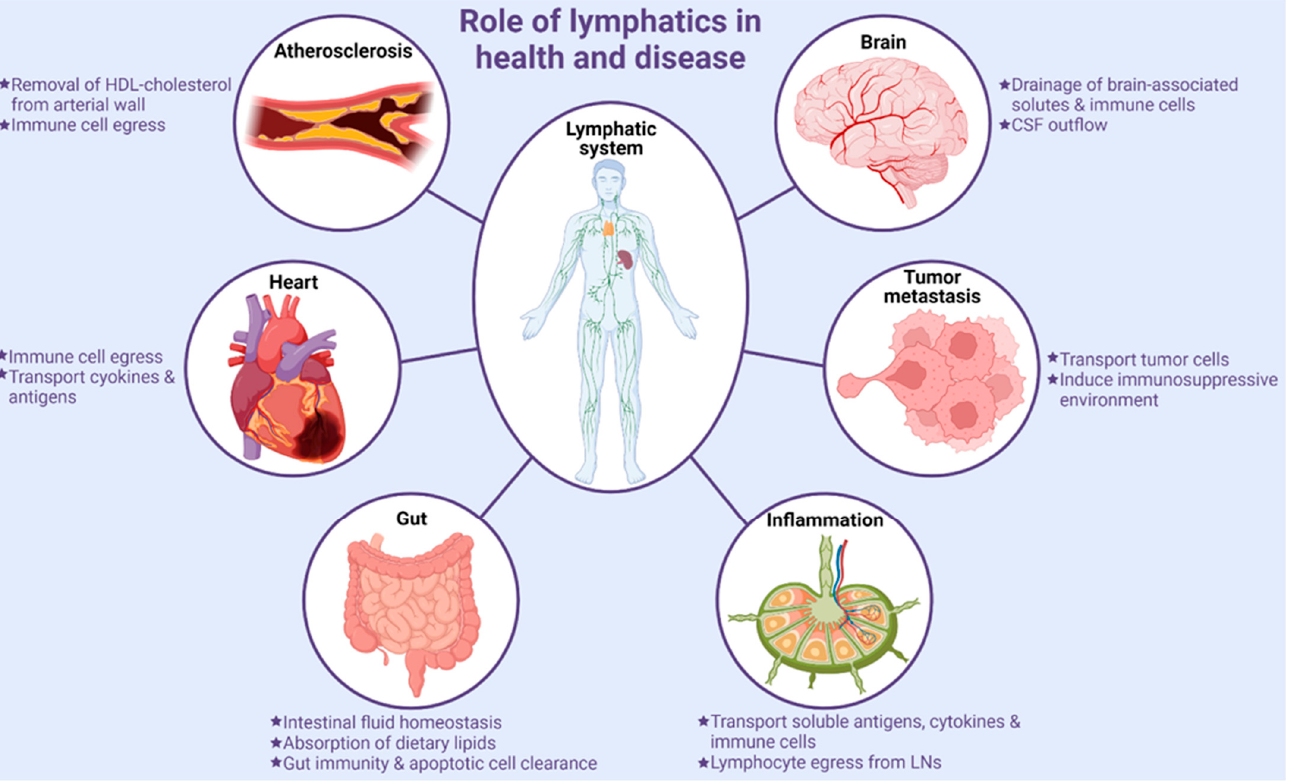
Figure 2. Role of the lymphatic system in health and disease.